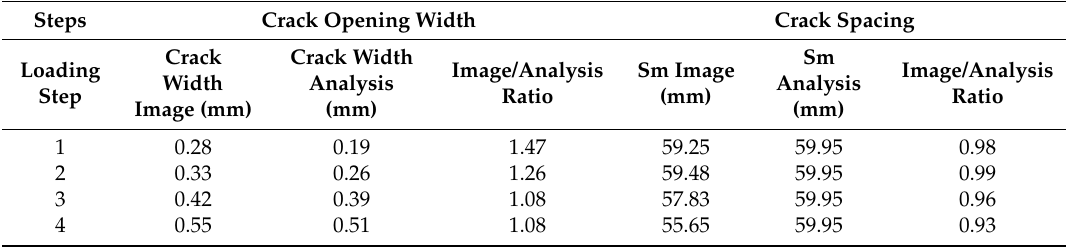
Table 6. Summary of obtained values as the average of the five